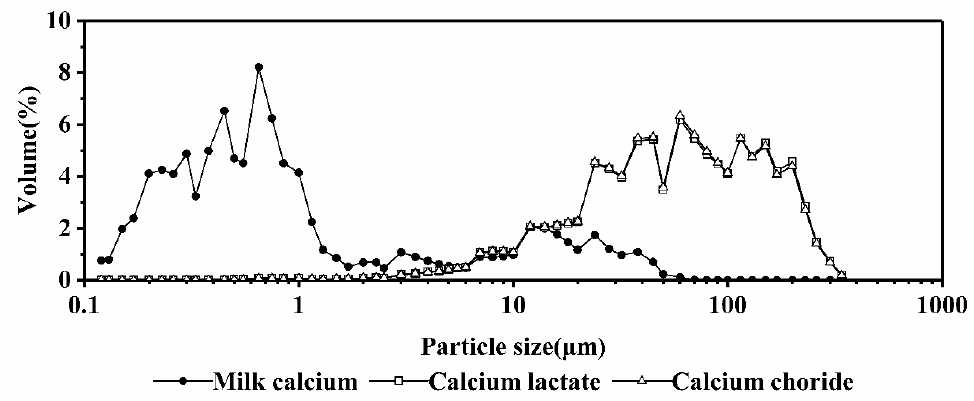
Figure 5. The particle size distribution of different calcium-fortified milk systems at 95 °C.